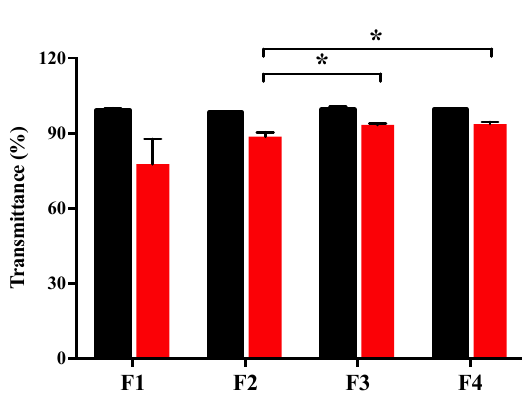
Figure 7. Stability evaluation of precipitation after thermal condition (121 °C, 30 min) of each formulation ( n = 3). Black or red bars represent the pre- or post-heating condition, respectively. * p < 0.05, significantly di ff erent from the F2